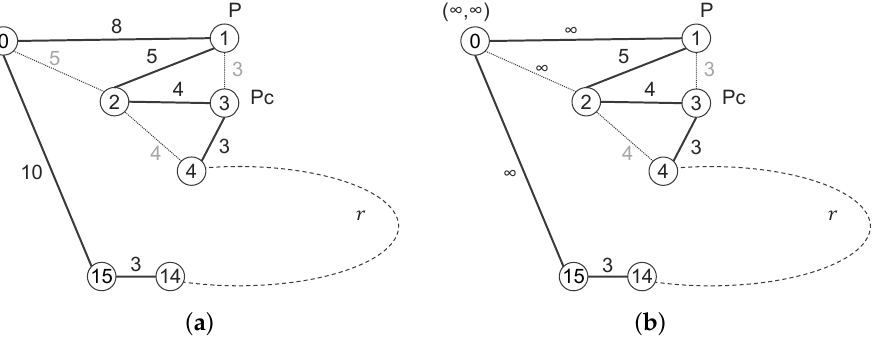
Figure 6. Example with virtual point explaining subtour optimization: ( a ) closed-loop tour; ( b ) open-loop subtour with virtual point at infinite location. Black, grey, and dashed lines show current edges, possible edges after permutation, and arbitrary sequence of points, respectively. See text for further